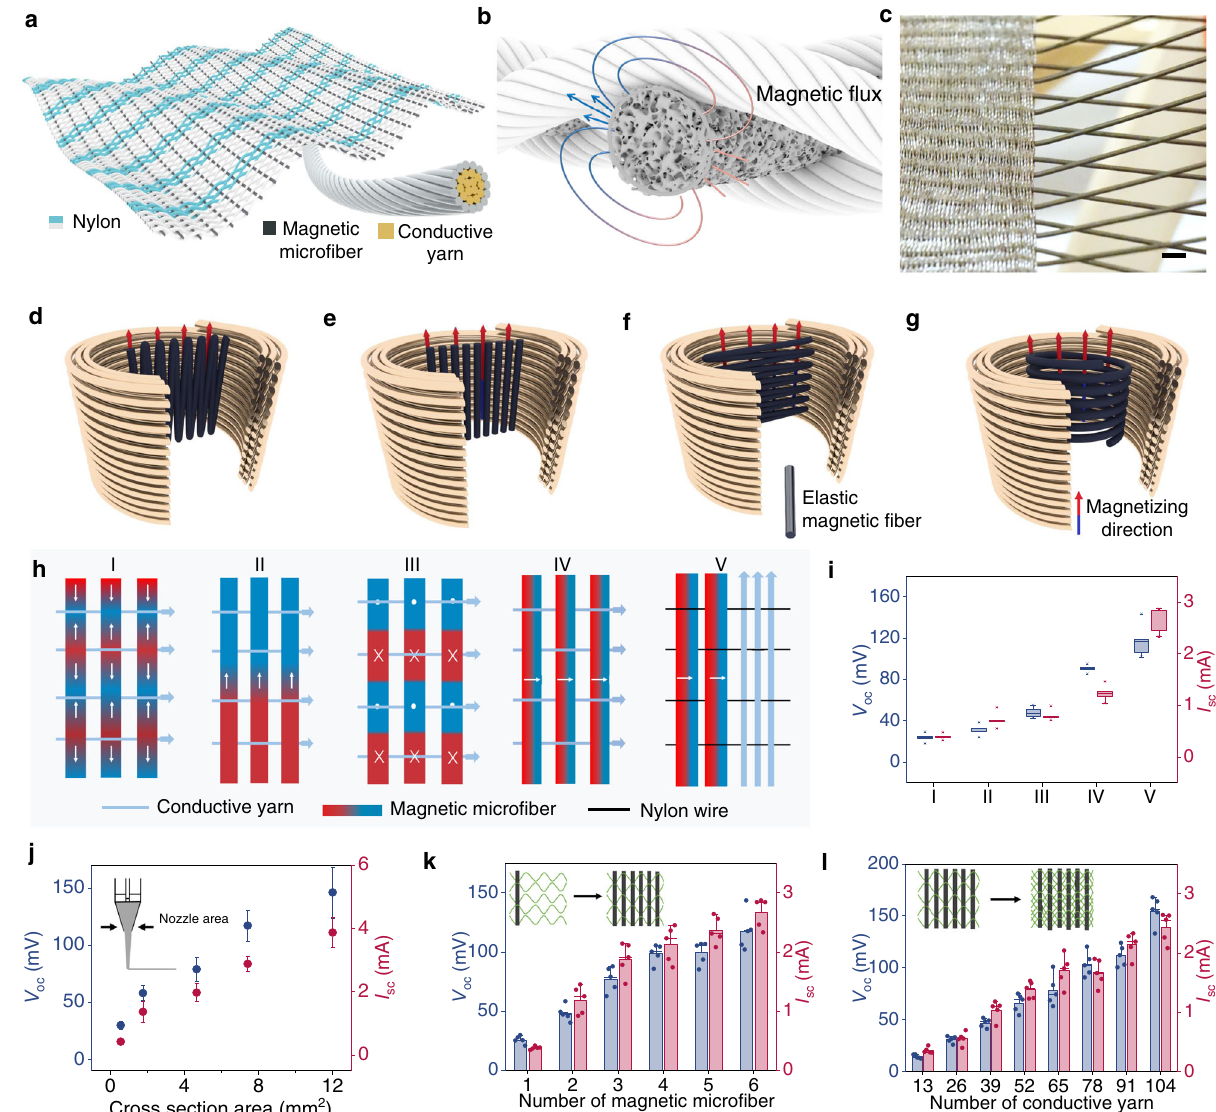
Fig. 2 Designing a textile MEG. a Schematic design of the textile MEG. b Schematics of the working mechanism of the textile MEG. c Photograph showing the weaving processing with a loom. Scale bar: 1 cm. d – g Schematics of parallel folded magnetic fi ber ( d ), straight magnetic fi ber ( e ), perpendicular folded magnetic fi ber ( f ), and annular folded magnetic fi ber ( g ) with an applied magnetic fi eld. h Schematics of textile MEGs with fi ve folding patterns. i Dependence of the short-circuit current ( I sc ) and open-circuit voltage ( V oc ) of the textile MEGs on different folding patterns. The boxplots show maximum, minima, median and upper and lower quartiles. j – l Dependence of the electrical output of the textile MEGs on ( j ) the cross-section area of the magnetic fi bers. Data are mean ± SD; n = 5. k The number of the magnetic fi bers. Each dot represents the result of a single test. Data are mean ± SD; n = 5. l The number of the conductive yarns. Each dot represents the result of a single test. Data are mean ± SD; n =